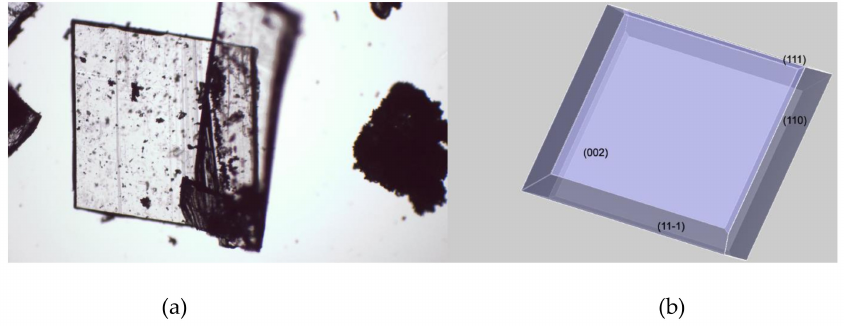
Figure 4. Crystal morphology comparison between the OM collected images ( a ) and the calculated crystal habit ( b ). Miller Indices are reported on the morphologically important (MI) faces.